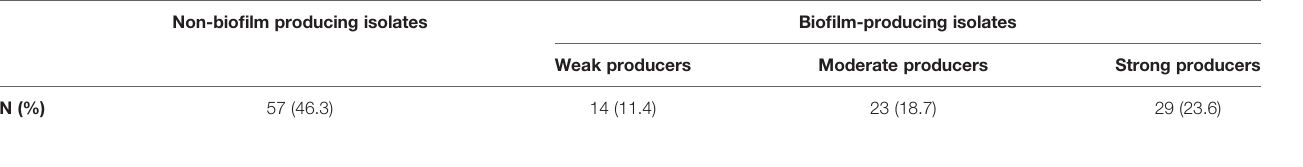
TABLE 2 | Bio fi lm production capacity of study